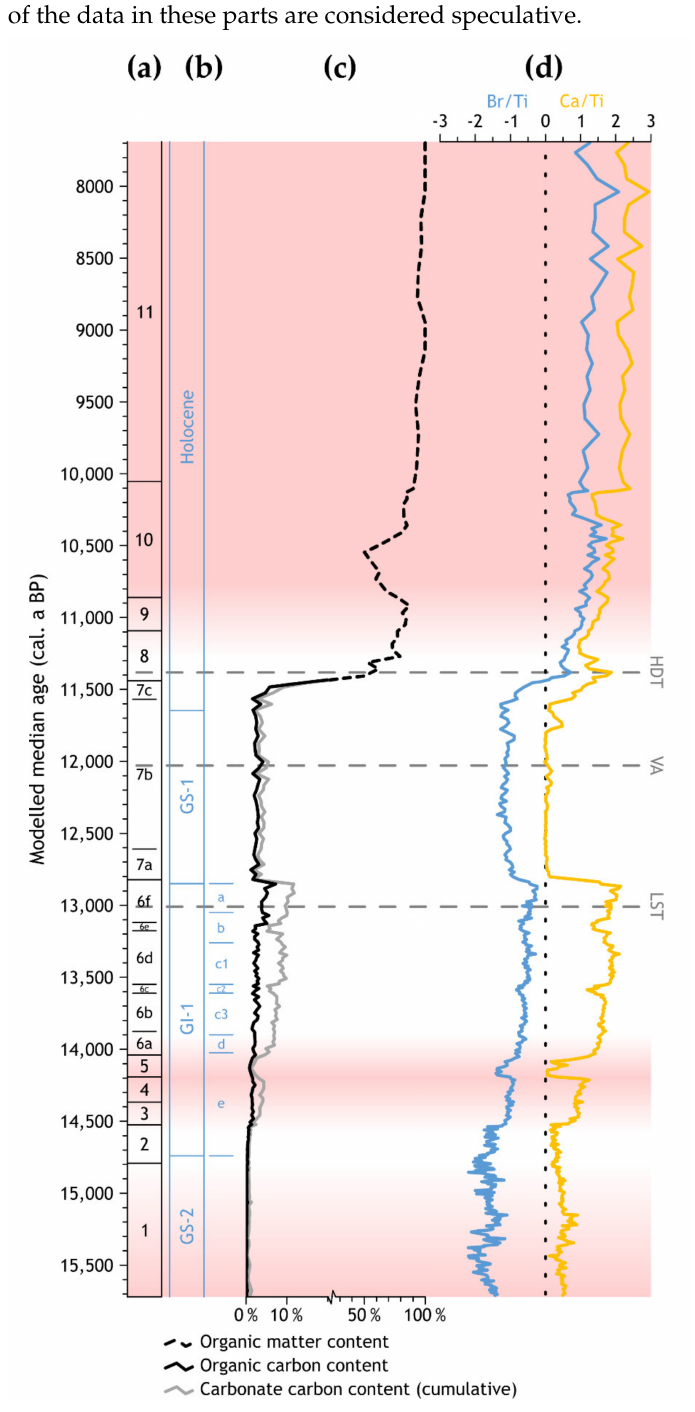
Figure 3. ( a ) Stratigraphic units, ( b ) Greenland ice-core record event stratigraphy [2], ( c ) organic matter and carbon contents (NB: broken axis), and ( d ) µ -XRF core-scanning results projected to modelled median ages from the age–depth model of the recently published study by Larsson & Wastegård (2022) [55] (as log-ratios of 10-point running means at a 1-cm resolution, dotted line shows 0 for reference). Red shading indicates where the age–depth model is less reliable. The positions of the Hässeldalen Tephra (HDT), the Vedde Ash (VA), and the Laacher See Tephra (LST) relative to the proxy results are indicated across the graph by dashed grey